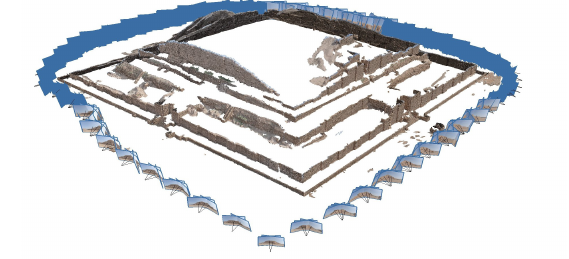
Figure 8. Camera poses of HAOUAV Data Set, which consists of two circular sequences around the Ziggurat.